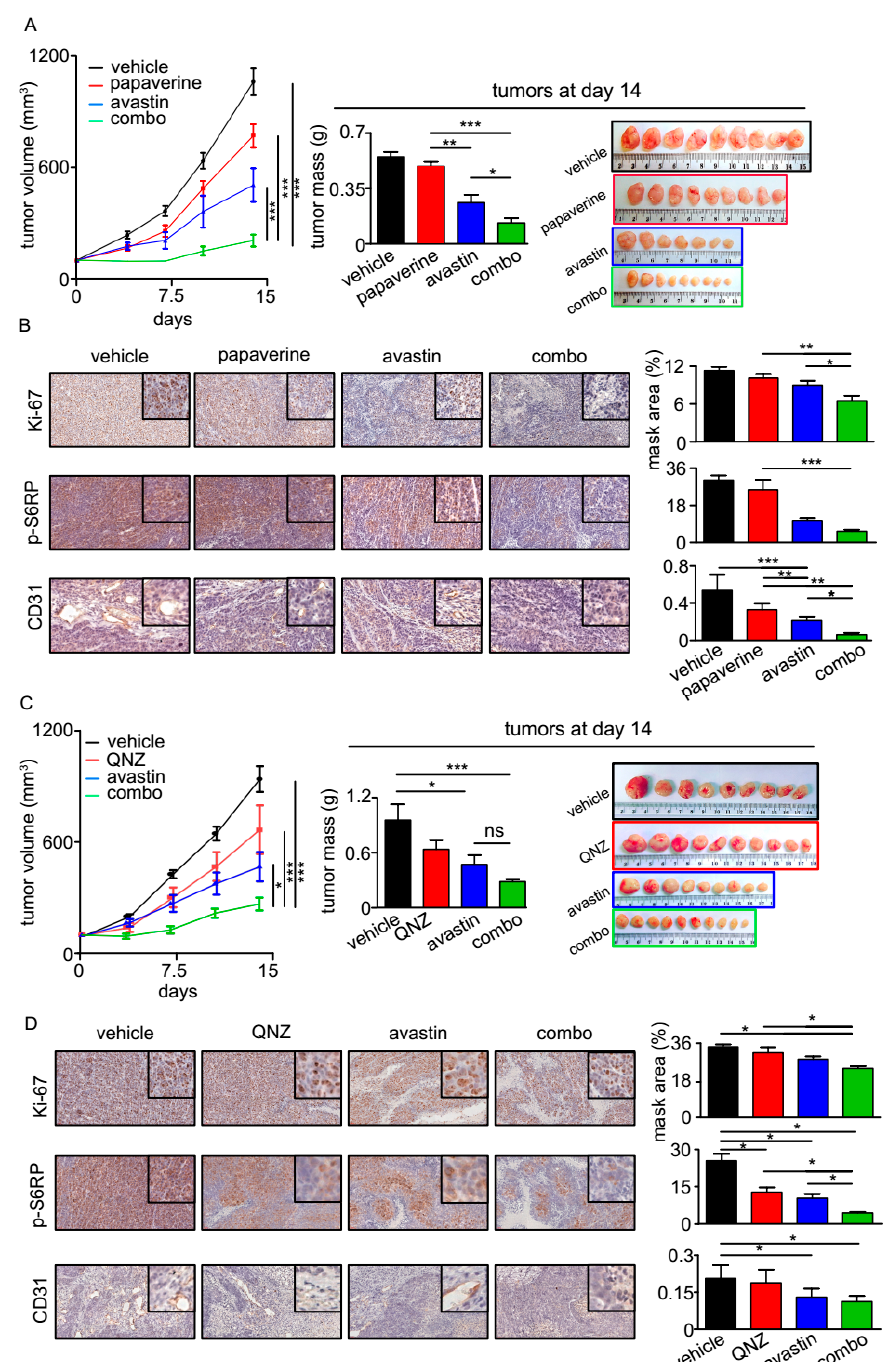
Figure 5. Combinations of bevacizumab with QNZ or papaverine delay tumor progression in vivo. ( A ) Tumor volumes of DLD1 cell xenografts in NOD–SCID mice; 5 × 10 6 DLD1 tumor cells were injected subcutaneously. Mice were randomized into 4 groups (n = 9–10). Mice were treated with bevacizumab (5 mg/kg/2 w) via intraperitoneal (IP) injection along with either QNZ (left) (1 mg/kg/d) or papaverine (left) (10 mg/kg/d), administered by gavage. ( B ) Representative staining for Ki-67, p-S6RP, and CD31. Statistical significance was calculated on end points using one-way ANOVA.